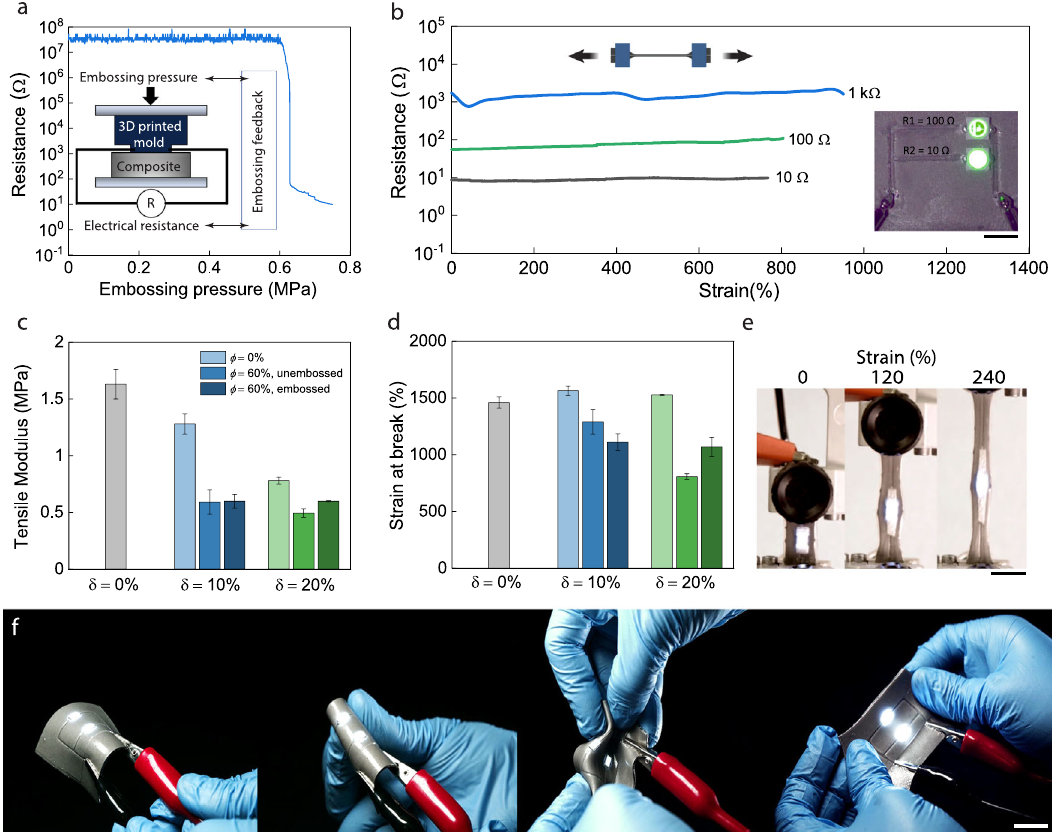
Fig. 3 Electromechanical properties of the soft conductive traces. a A plot and schematic illustrates the embossing procedure with feedback control. b A plot of resistance vs. applied tensile strain of three different conductive traces embossed to resistances R = 10 Ω , 100 Ω , and 1 k Ω ( ϕ = 60%, δ = 20%). The inset shows a photograph of embossed traces with R 1 = 100 Ω and R 2 = 10 Ω being used as resistors to change LED brightness (scale bar — 5 mm). c Tensile modulus and d strain at break of an un fi lled elastomer, pristine (unembossed), and embossed composite. e Stretching of an LED integrated with embossed traces (scale bar — 10 mm). f A composite with ϕ = 50% used to create an LED circuit to illustrate the robustness of the traces in operation — bending, folding, twisting, and stretching (scale bar — 10 mm). Error bars denote standard deviations for n = Figure 3a inset shows a schematic of the embossing setup with a representative curve of electrical resistance as a function of stress during embossing. The compressive load applied through a mechanical testing machine is controlled, while simultaneously measuring the resistance through a source meter. This synchro- nous setup facilitates the tuning of resistance and load applied, where either of these parameters can be used to trigger and start/ stop the test. In a typical embossing step, as the load is being applied, the measured resistance remains at a high level of ~10 7 Ω until a threshold point, when it quickly drops and then decreases gradually with further application of load (Fig. 3a). Utilizing the designed embossing setup allows for tunable resistance based on embossing load. The applied load is increased until a target resistance is obtained, then the load is automatically stopped by sending an electronic trigger to the mechanical testing machine.